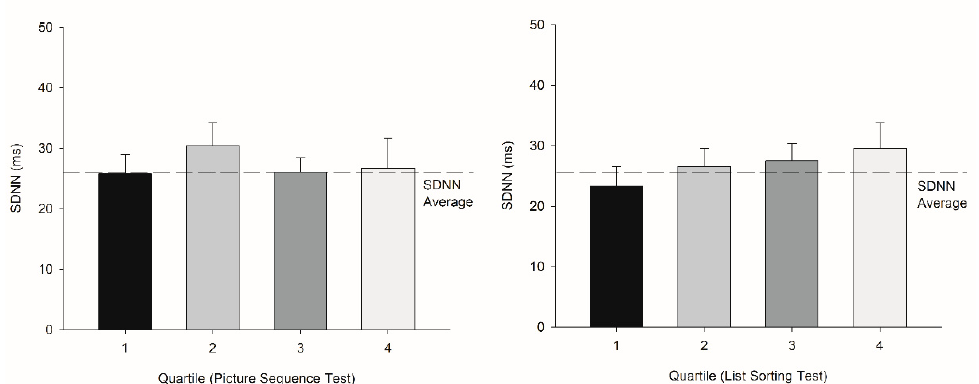
Figure 4. Upper left: Quartile comparisons (determinants: DCCS) in terms of SDNN (error bar: SE) did not demonstrate any significant differences. Upper right: Quartile comparisons (determinants: Flanker) in terms of SDNN did not demonstrate any significant differences. Lower left: Quartile comparisons (determinants: Picture Sequence) in terms of SDNN did not demonstrate any significant differences. Lower right: Quartile comparisons (determinants: List Sorting) in terms of SDNN did not demonstrate any significant differences.